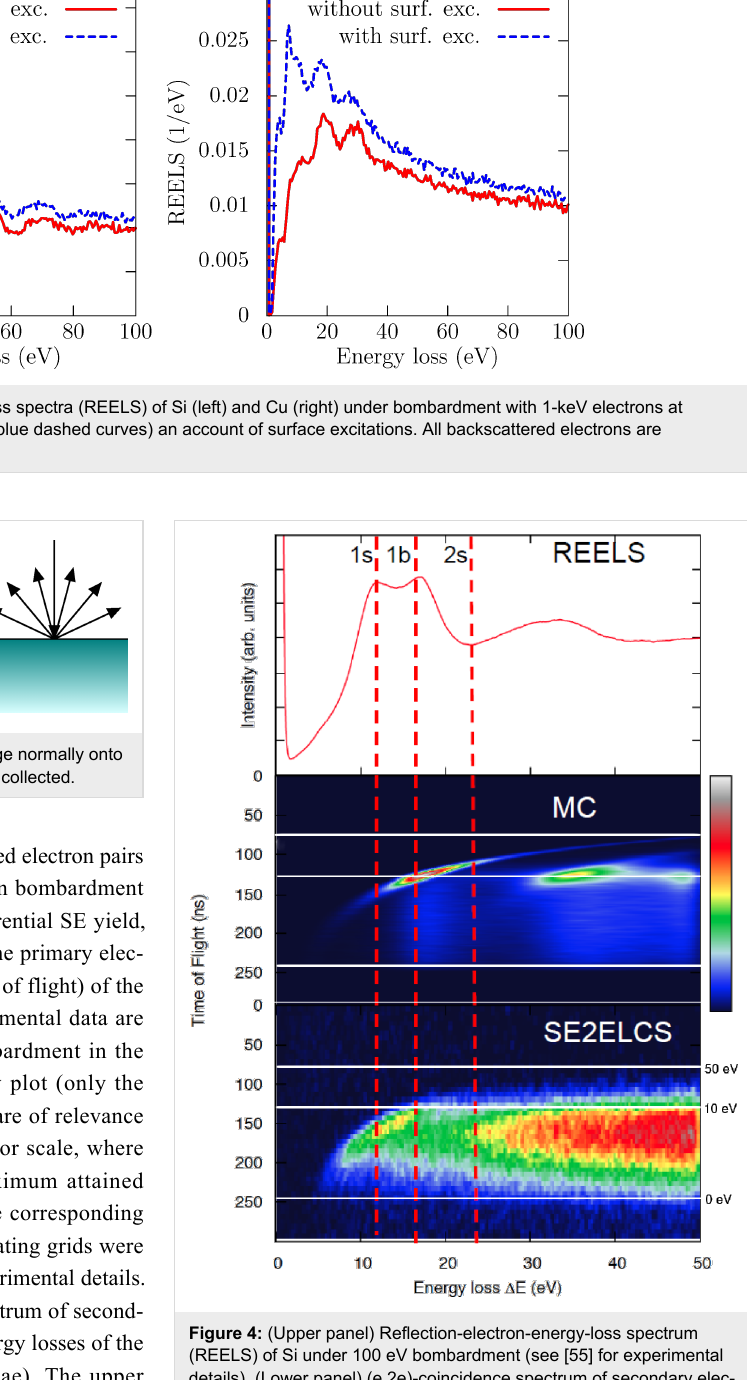
Figure 4: (Upper panel) Reflection-electron-energy-loss spectrum (REELS) of Si under 100 eV bombardment (see [55] for experimental details). (Lower panel) (e,2e)-coincidence spectrum of secondary elec- trons emitted in coincidence with energy losses (SE2ELCS) of 100-eV electrons backscattered from Si. (Middle panel) Monte-Carlo simula- tion of the SE2ELCS measurement without accounting for surface energy losses. The vertical dashed lines in red indicate energy losses corresponding to the excitation of one surface, one bulk, and two surface plasmons. The horizontal solid white lines indicate the times of flight corresponding to electrons with 0 eV (accelerating grids were used), 10 eV, and 50